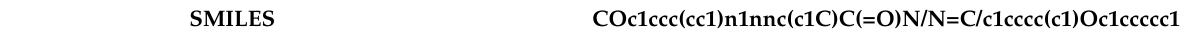
Table 8. Physicochemical, lipophilicity, water solubility, pharmacokinetic, drug-likeness, and medici- nal chemistry properties obtained from the SwissADME website for 2